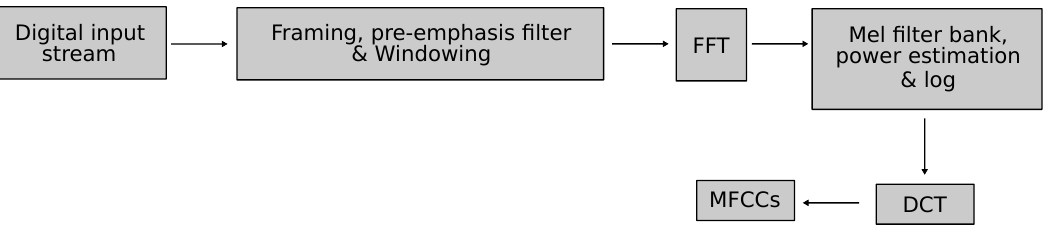
Figure 2. Mel Frequency Cepstrum Coefficient (MFCC) calculation